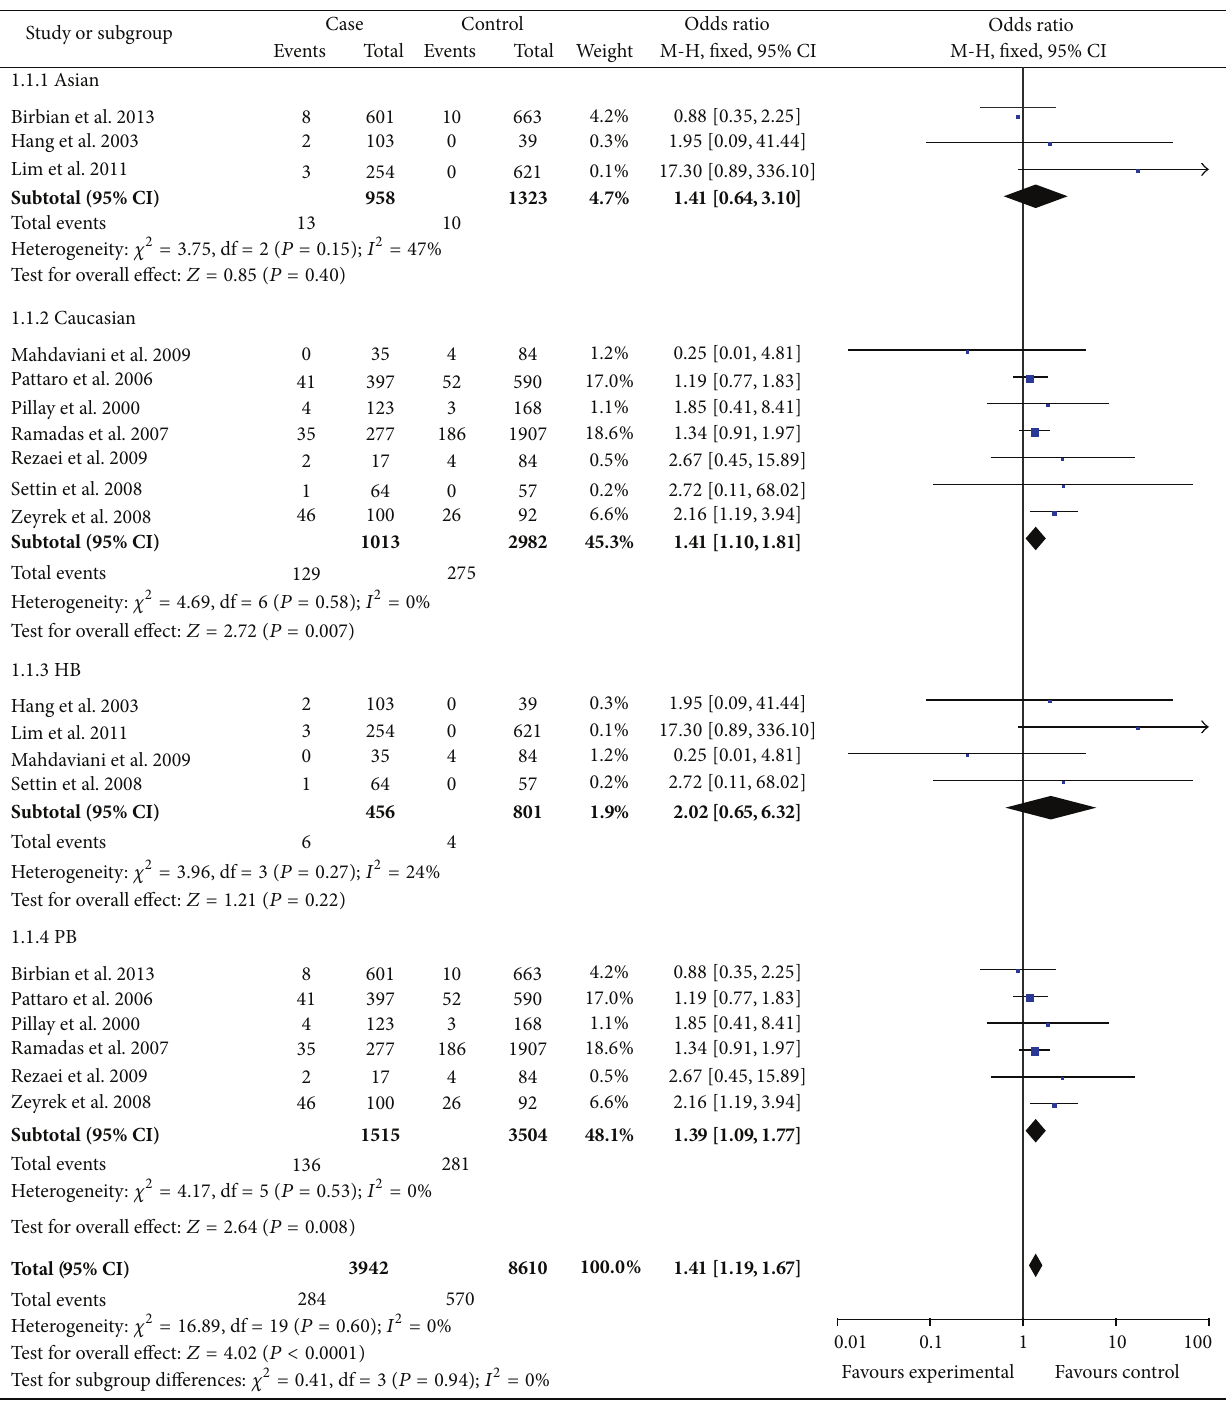
Figure 3: Forest plot the IL-1RA polymorphism and asthma risk (AA versus